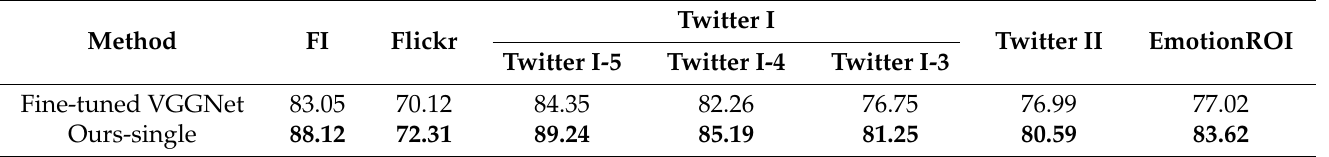
Table 4. The model performance comparison across image datasets. Results with bold indicate the best results compared with other